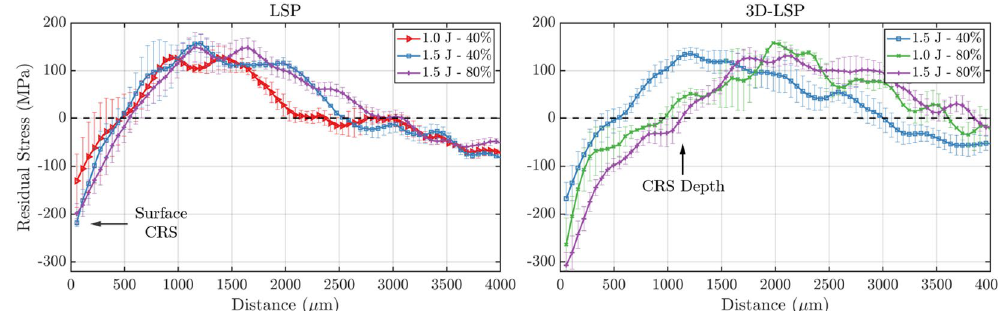
Figure 4. Average residual stress (MPa) as a function of distance from the top sample surface for different LSP process parameters. The plots are grouped depending on whether they are treated by conventional LSP (left) or 3D-LSP (right). The color code and marker style are unique to each specific LSP process parameters.